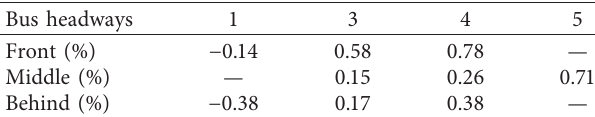
Table 4: Bus headways relative difference compared with group S2.